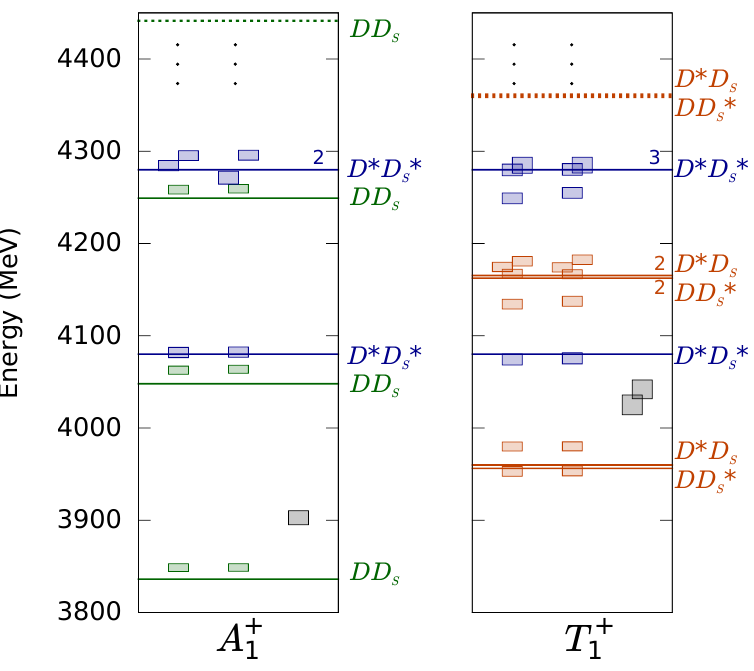
Figure 7 . As (cid:12)gure 6 but for the isospin- 1